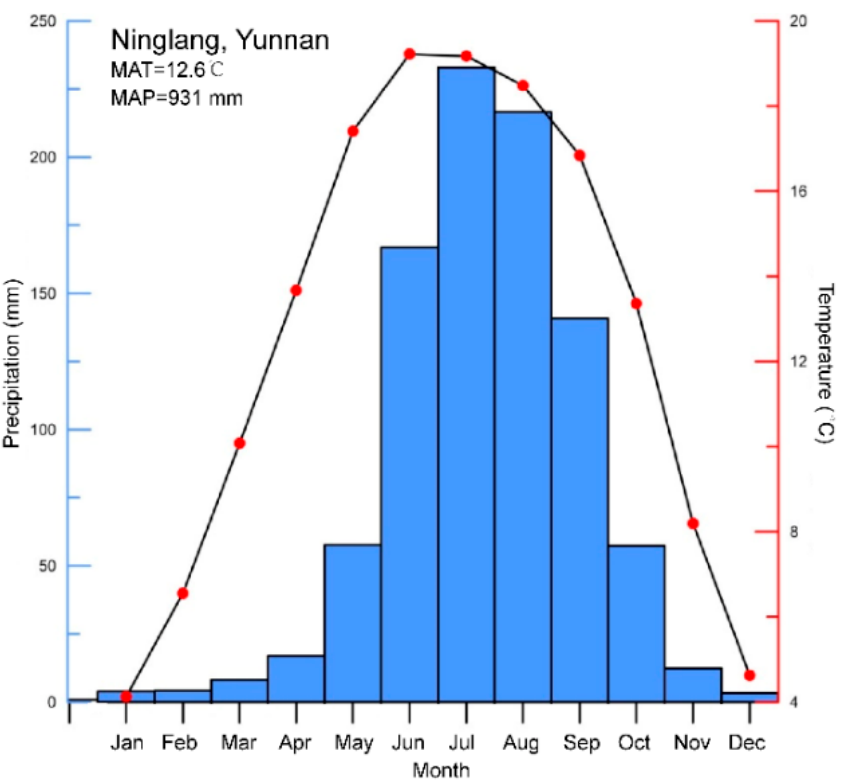
Figure 2. Monthly mean precipitation and temperature from 1961 to 2010 at Ninglang meteorological station near Lugu Lake in northwestern Yunnan, China.